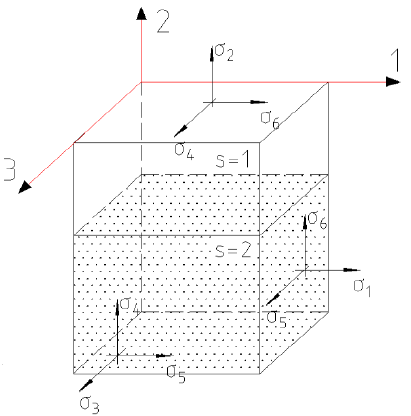
Fig. 1. The characteristic structural element of a nonhomogeneous